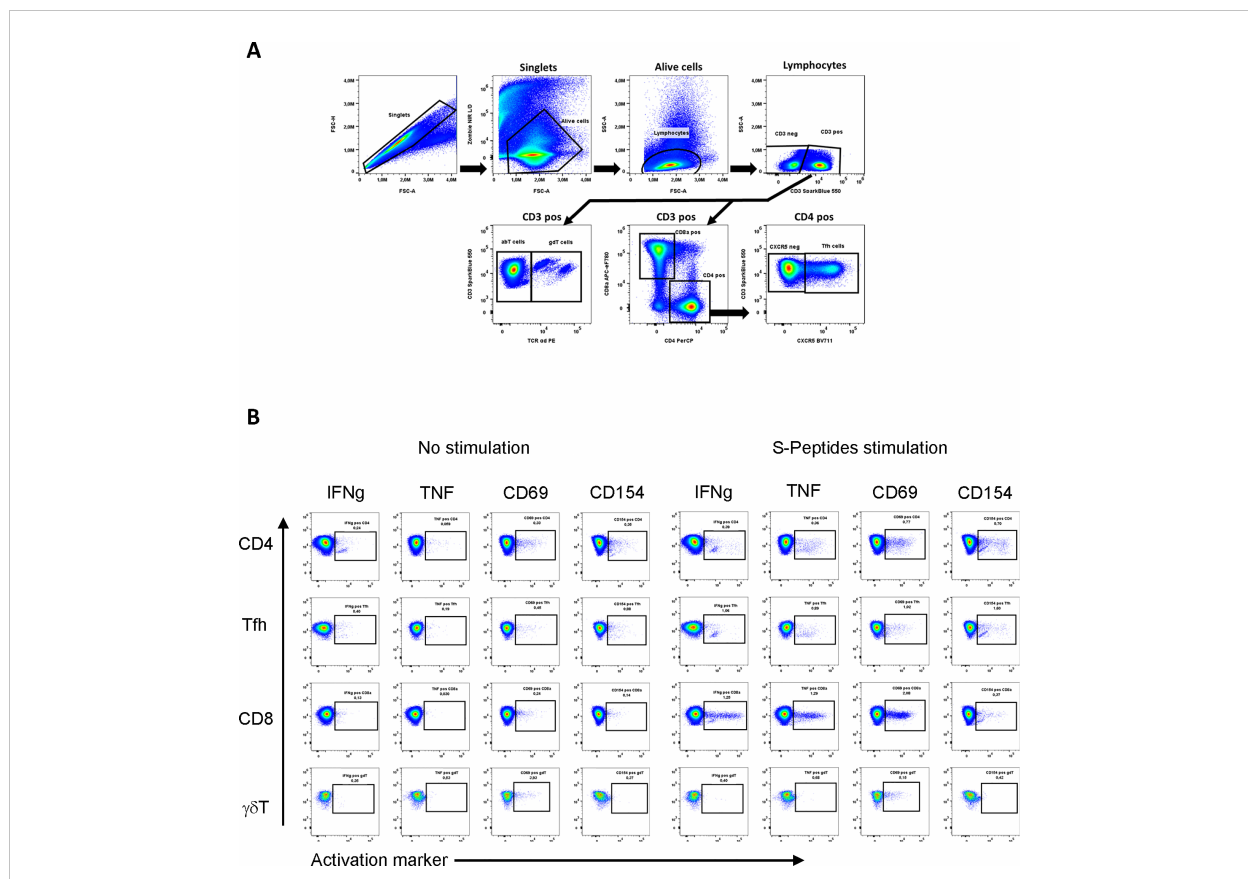
FIGURE 1 Flow cytometric analysis of SARS-CoV-2-speci fi c T cells after two vaccine doses. Gating strategy (A) and exemplary dot plots (B) of unstimulated and stimulated samples from one control subject. Cells of interest (CD4, CD8, Tfh, gd T) were gated as follows: After doublet and dead cell exclusion, lymphocytes were gated based on FSC-A/SSC-A properties. CD4+ (Th cells) and CD8a+ (Tc cells) T cells were identi fi ed out of the CD3+ gate. CXCR5+ (Tfh cells) were identi fi ed in CD3+CD4+ cells. In CD3+ cells, cells expressing TCR gd were de fi ned as gd TCR+ ( gd T cells). The same gating strategy has been applied for t-SNE analysis. T cells speci fi c for the spike protein of SARS-CoV-2 were identi fi ed after 6 h stimulation of total PBMC using overlapping peptides (S-Peptides), covering the complete sequence of the spike protein. After intracellular staining of cytokines and